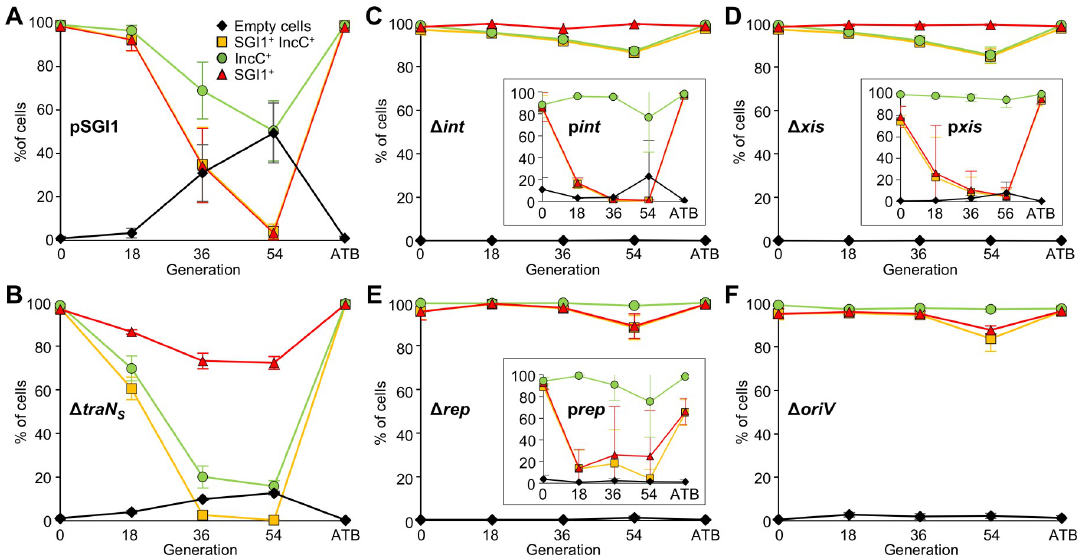
Fig 5. Impact of SGI1 replication on incompatibility. Evolution of the percentage of E . coli KH95 cells bearing either pVCR94 GreenSp (IncC) and pSGI1 (A) or pVCR94 Green (IncC) and the Δ traN (B), Δ int (C), Δ xis (D), Δ rep (E), or Δ oriV (F) mutants of SGI1 Red (SGI1) S over 54 generations in the absence of antibiotics as monitored by FC. Inserts for panels C, D and E show complementation experiments using the designated expression plasmid and pVCR94 GreenSp . Conditions were identical to Fig 2A. Plots represent the mean and standard error of the mean obtained from three independent experiments. Representative density plots of mNeongreen intensity over mCherry intensity and their corresponding plots of fluorescence intensity over forward scatter are shown for each condition in S1–S5 and S7